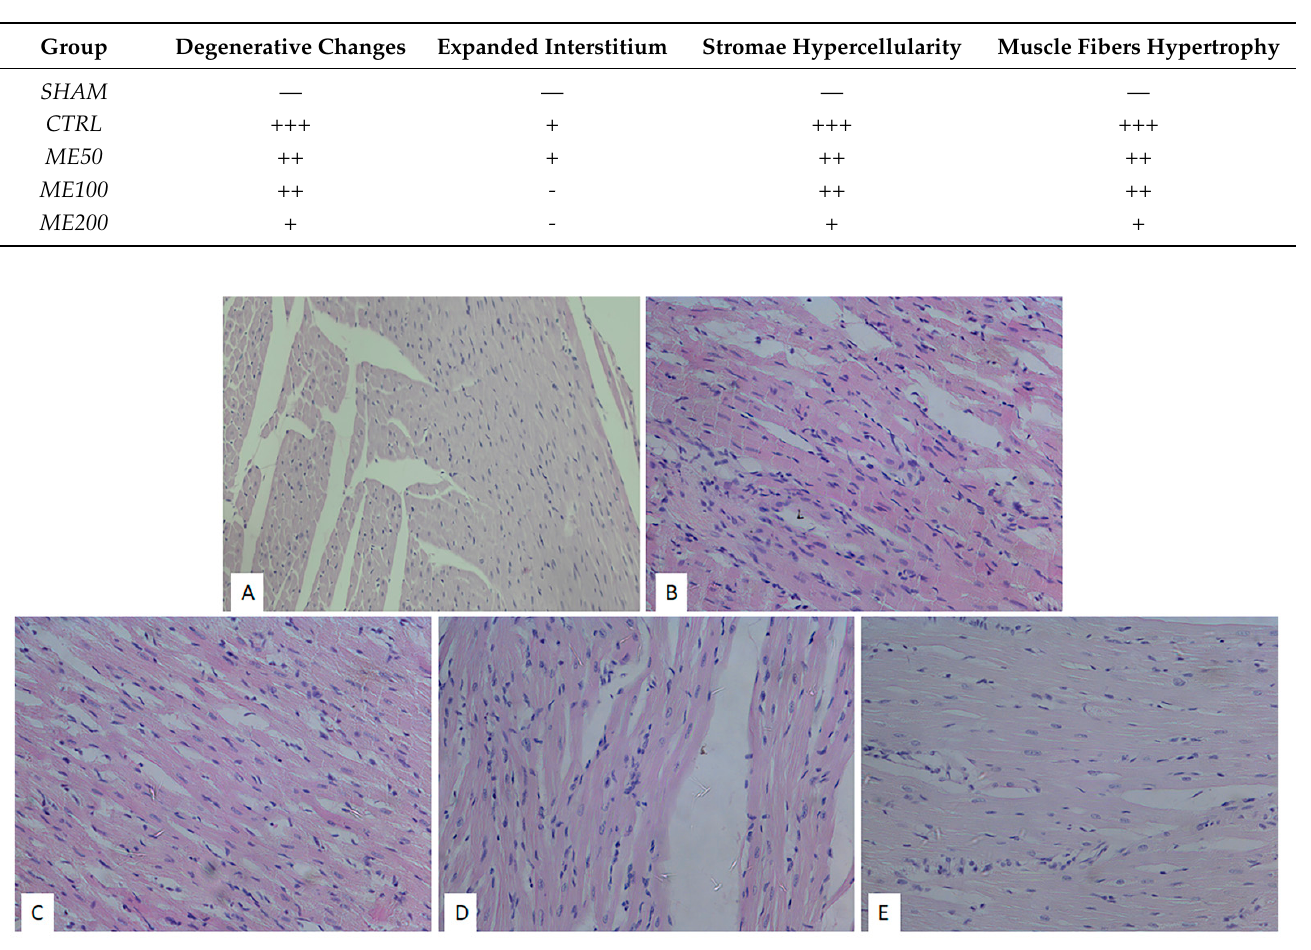
Figure 4. Effects of short-term heart preconditioning with ME on heart tissue morphology. Repre- sentative heart tissue sections of H/-E staining. Magnification 20 × scale bar = 50 µ m. ( A ) SHAM; ( B ) CTRL; ( C ) ME50; ( D ) ME100; ( E ) ME200. Table 1. Histopathological changes of myocardial tissue depending on the degree, presence, or ab- sence of degenerative changes, expanded interstitium, stromae hypercellularity, and muscle fibers hypertrophy.